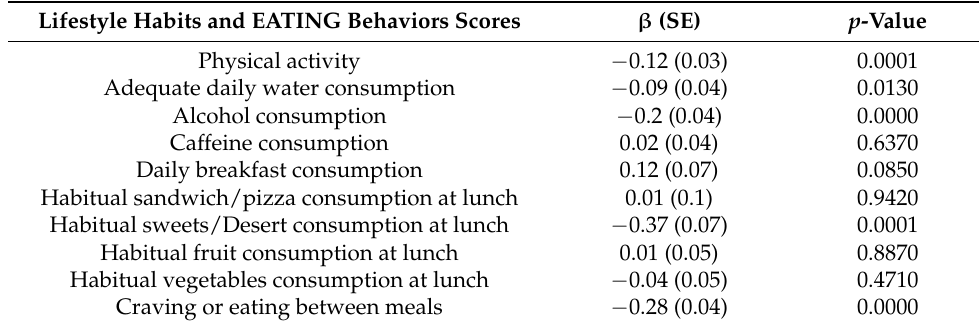
Table 2. Multiple regression analysis: ∆ BMI (Kg/m 2 ) was the dependent variable while lifestyle habits and eating behaviors scores were the independent ones.